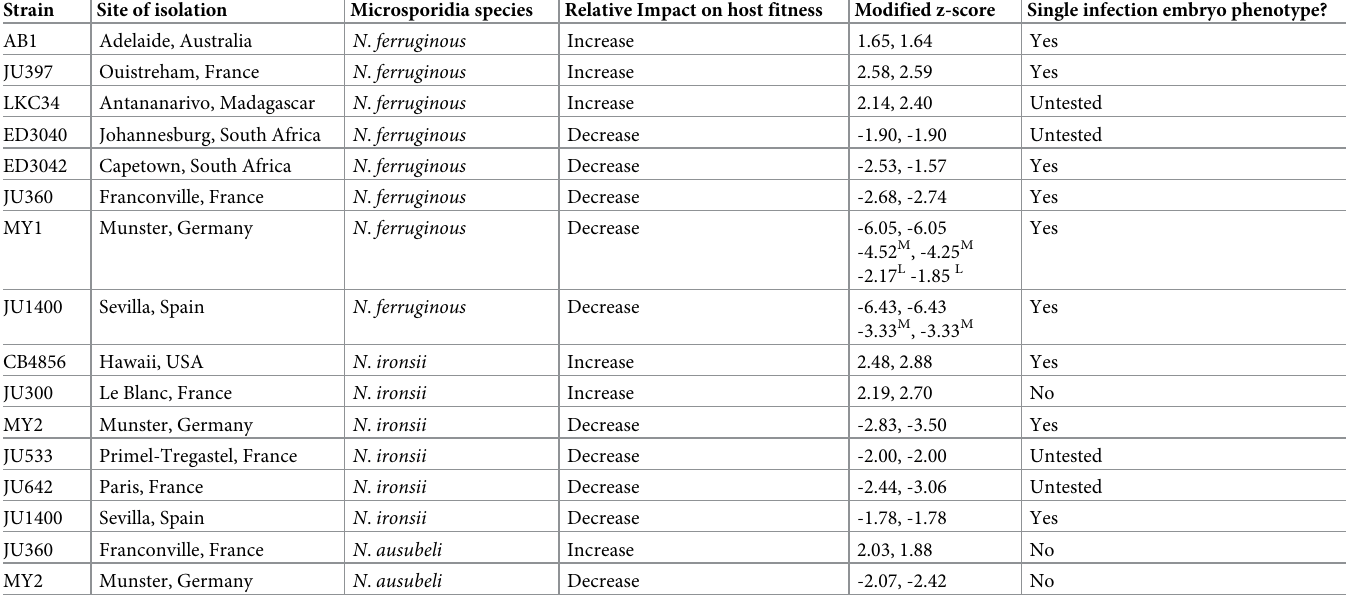
Table 1. PhenoMIP screen interaction